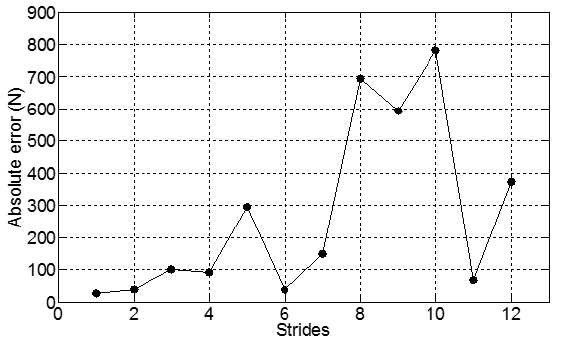
Figure 3. Absolute error of prediction for a model generated using data from the first 4 strides of the run for participant two, right shank sensor where c 1 = − 108, c 2 = 144 and c 3 =80.6.